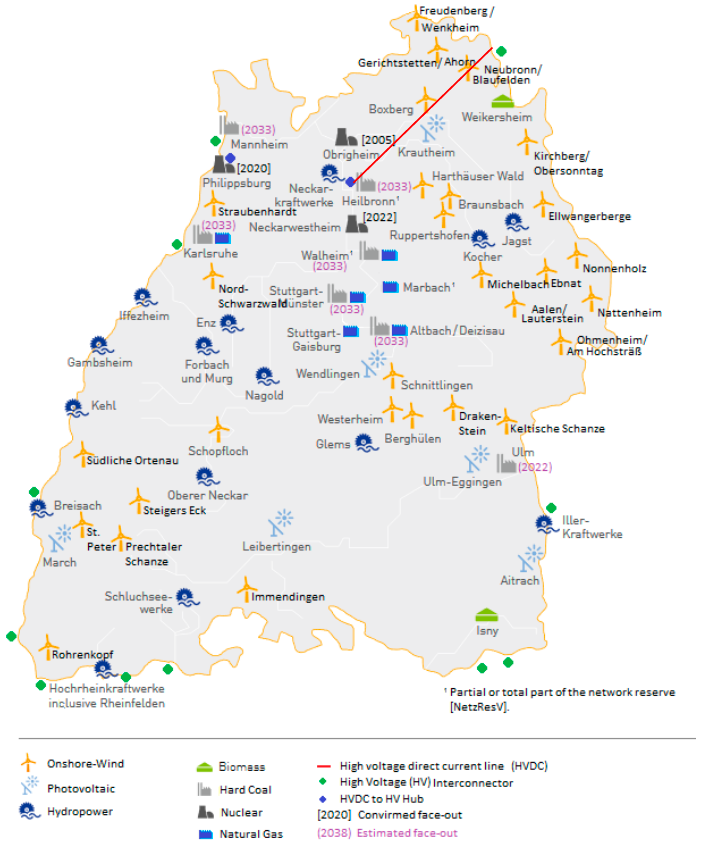
Figure 1. Map of Baden-Württemberg with the major production sides and face out times including high-voltage interconnector sides and high-voltage, direct current (HVDC) to HV hub sides [12–20]. Different approaches of modeling distribution grids are analyzed profoundly in many publications. Kriechbaum et al. [21] highlight the different modeling approaches and show use cases for them. In addition, distribution grid modeling techniques are of major importance in grid developing planning processes to evaluate the extent of future investments, as the BMWI [22] shows in their publication. However, few publications present and discuss models to analyze dynamic inflows to electricity grids in order to develop grid capacities systematically and support distribution grid operators in the remuneration of their grids given typical grid loads.